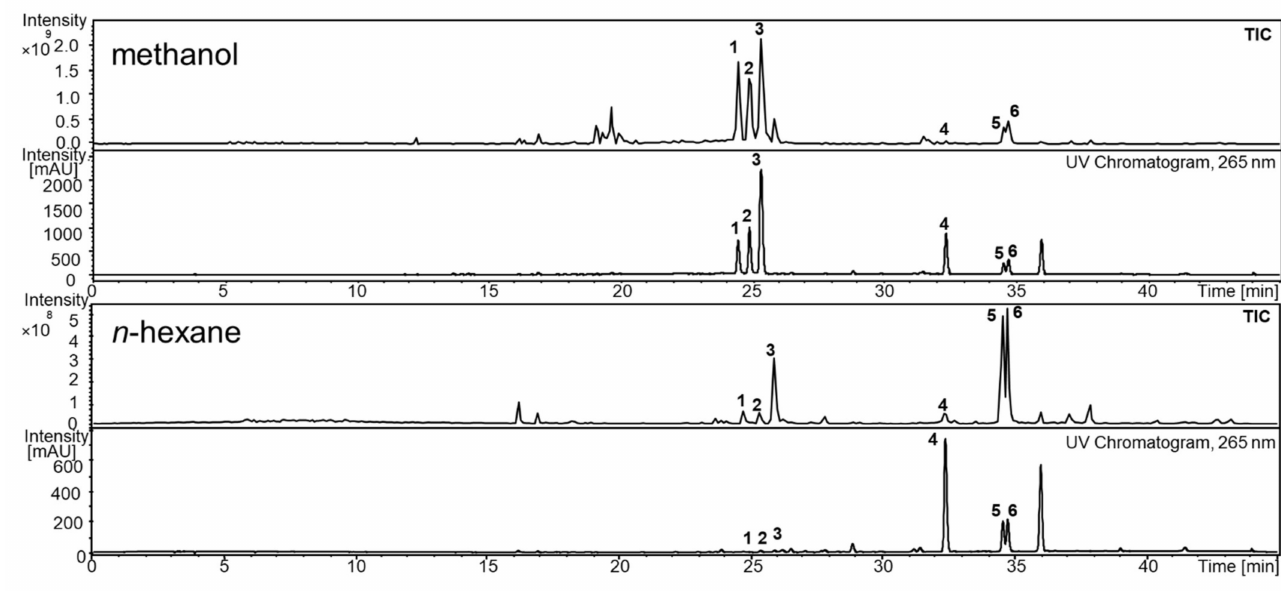
Figure 2. Total ion current (TIC) and UV chromatogram of methanol and n -hexane extracts;